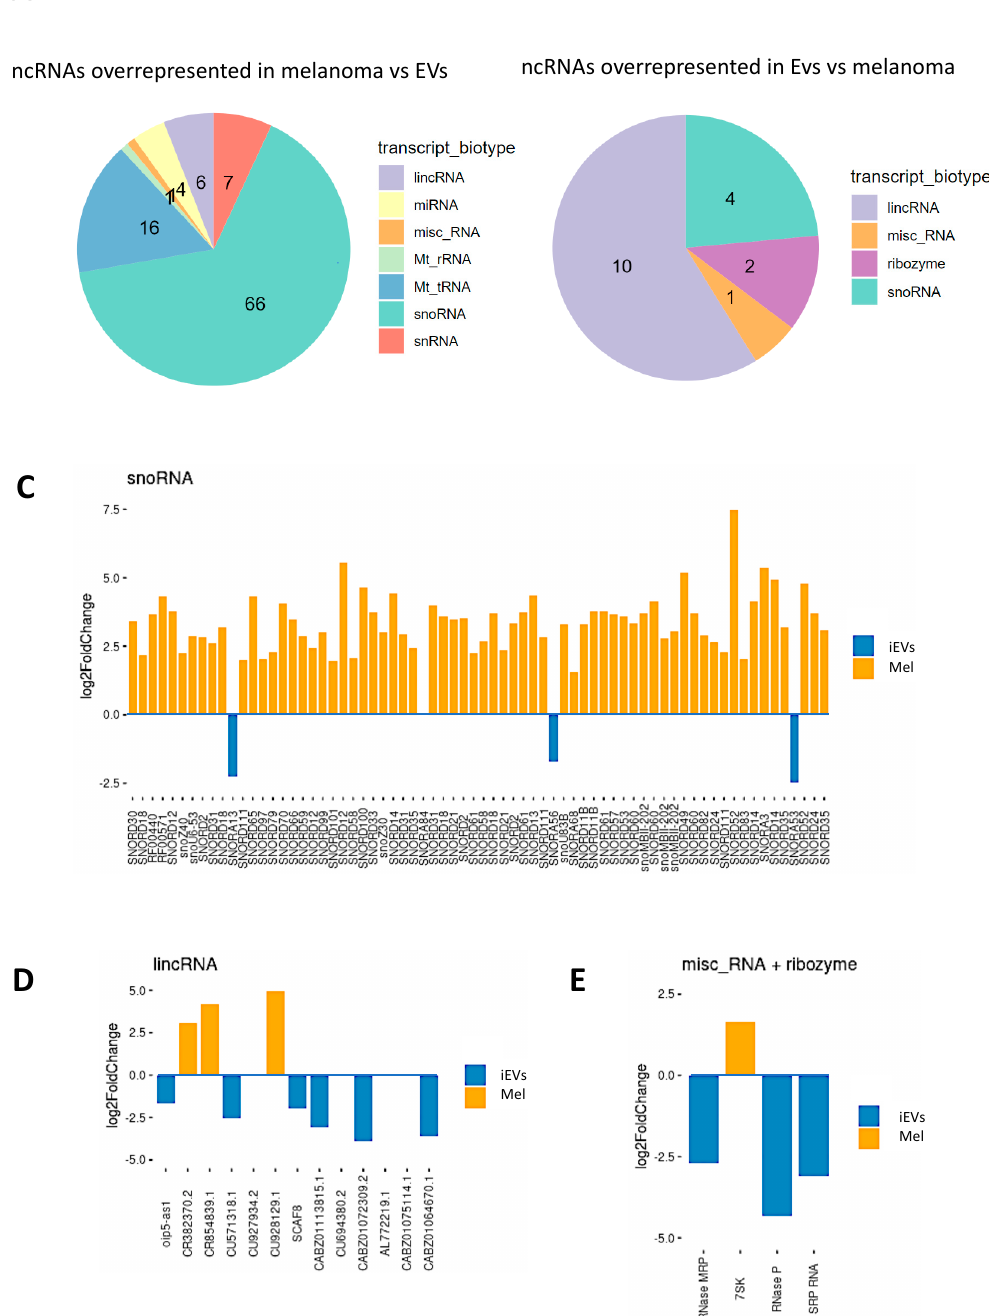
Figure 3. Analysis of ncRNA in iEVs and melanoma. ( A , B ) Pie charts representing the different ncRNA species found enriched in melanoma ( A ) and in their iEVs ( B ). ncRNAs were considered differentially expressed with adjusted p -value < 0.05 and a log2 fold change greater than 1 or smaller than − 1. ( C – E ) Representation of the three main categories of differentially enriched species of ncRNAs (orange bars: enriched in melanoma, blue bars, enriched in iEVs) and their identity. Misc_RNA: miscellaneous